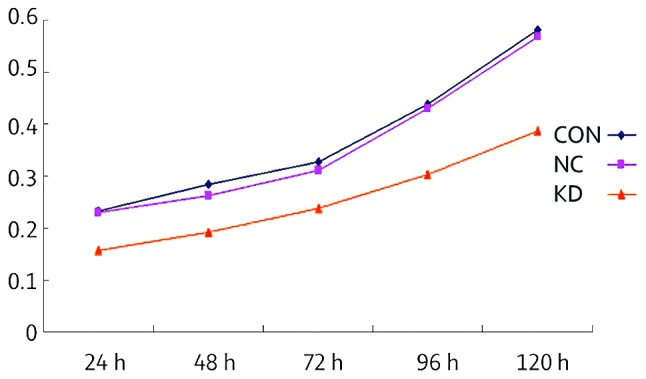
Effect of Cyclooxygenase-2 gene silencing on SKOV3 proliferation ability. CON, control; NC, negative control; KD, interference group. Y-axis denotes optical density.